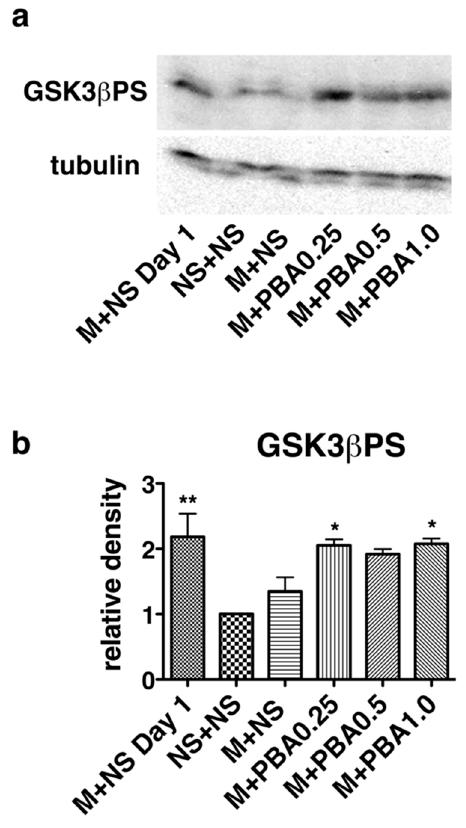
Figure 6. GSK3 β activation was reduced in the mice treated with morphine and pharmacological ER chaperones. Mice received intraperitoneal morphine (M, 20 mg / kg) and oral saline (NS, 300 µ L) or 4-phenylbutyrate (PBA; 0.25, 0.5, 1.0 g / kg) twice a day for 5 days. Brains were removed and section after the first injection on day 1 or the tenth injection on day 5. Brainstem expression levels of phosphorylated Ser9 of GSK3 β (GSK3 β PS) and tubulin were evaluated by western blotting ( a ). GSK3 β inactivation was assessed by comparing the relative density (arbitrary units) of the GSK3 β PS band to that of tubulin ( b ). The means ± standard error of the mean for three experiments are reported. The GSK3 β PS values represent the relative values compared to those in mice treated with intraperitoneal saline and oral saline for 5 days (standardized as 1.0 in each experiment). The GSK3 β PS values of mice given morphine and saline once (M+NS day 1) and mice receiving morphine and PBA (0.25, 1.0 g/kg) twice a day for 5 days were significantly higher than those of control mice (saline only; NS+NS). * p < 0.05, ** p < 0.01, one-way analysis of variance with Bonferroni post-hoc test.